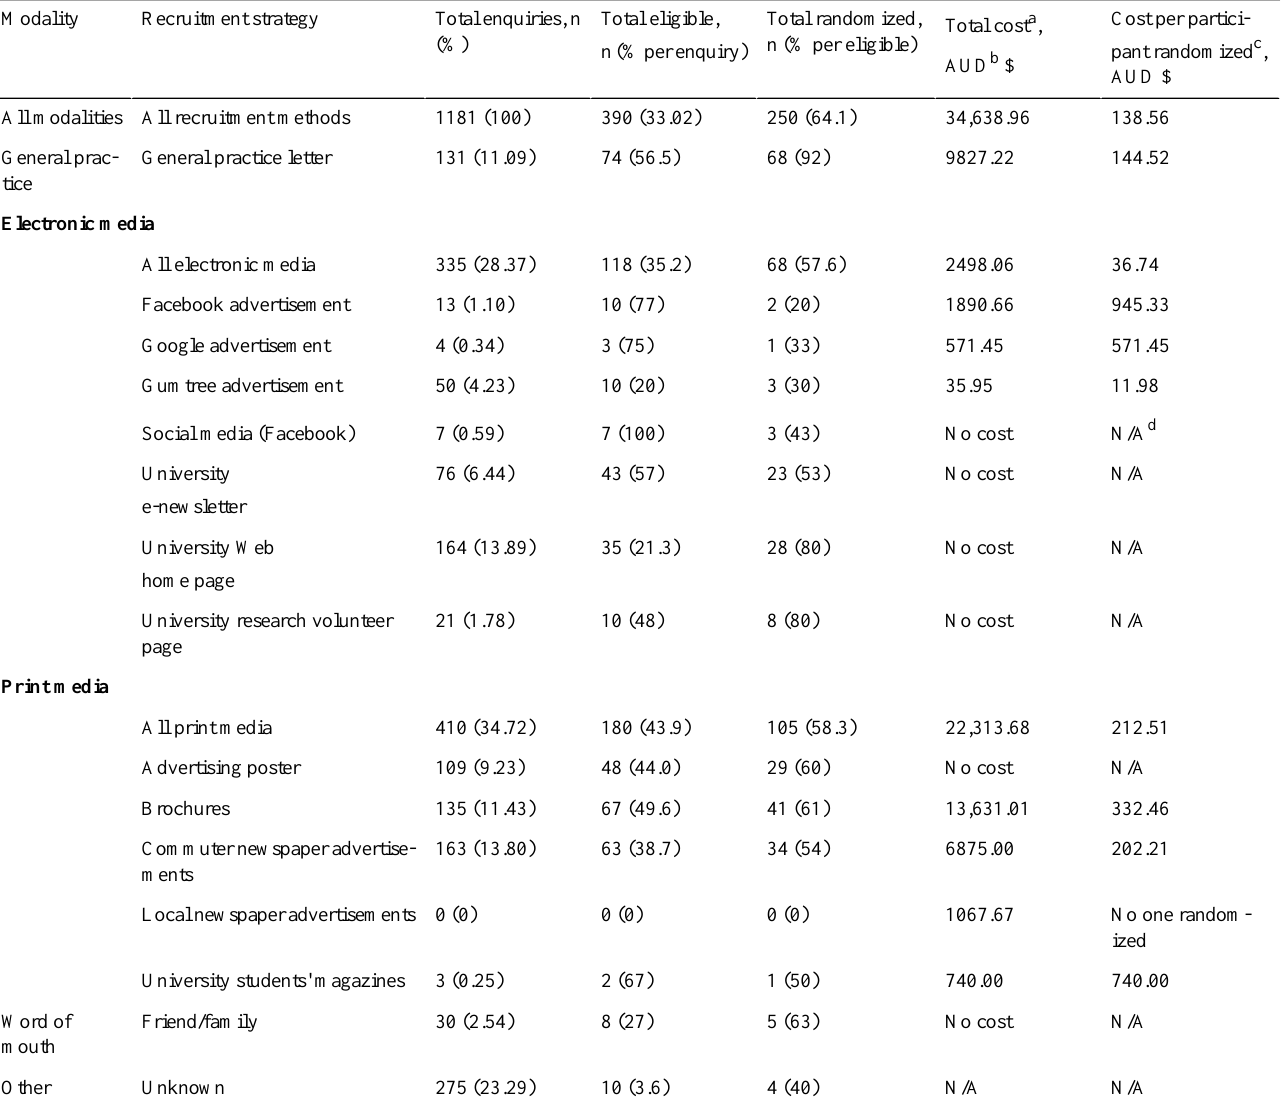
Table 2. Total enquiries, eligible and randomized, and cost (AUD $) per recruitment strategy for the TXT2BFiT